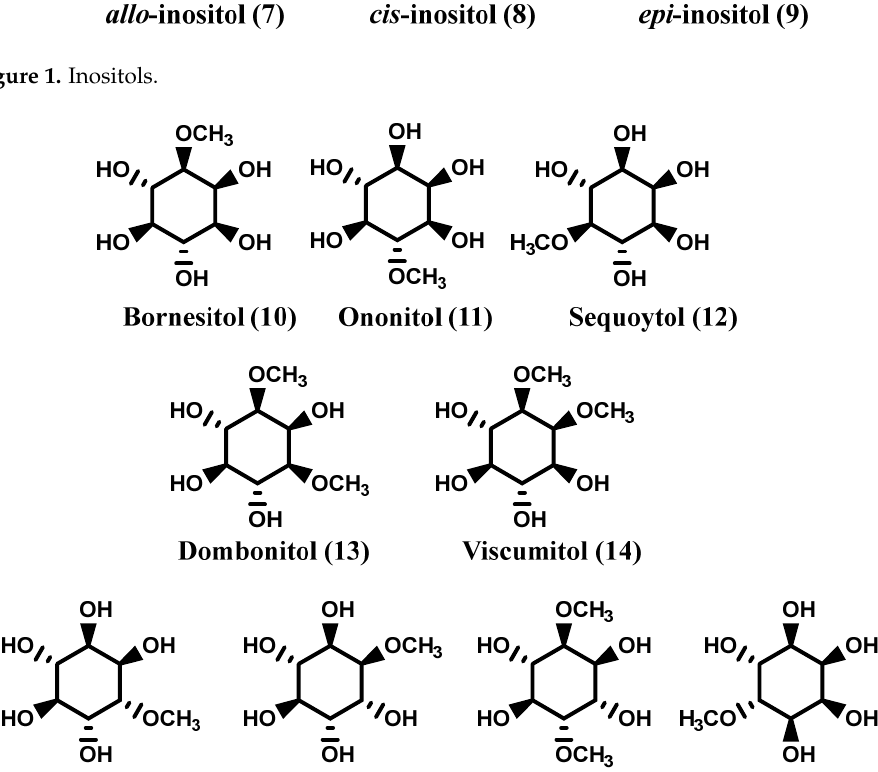
Figure 1. Inositols.